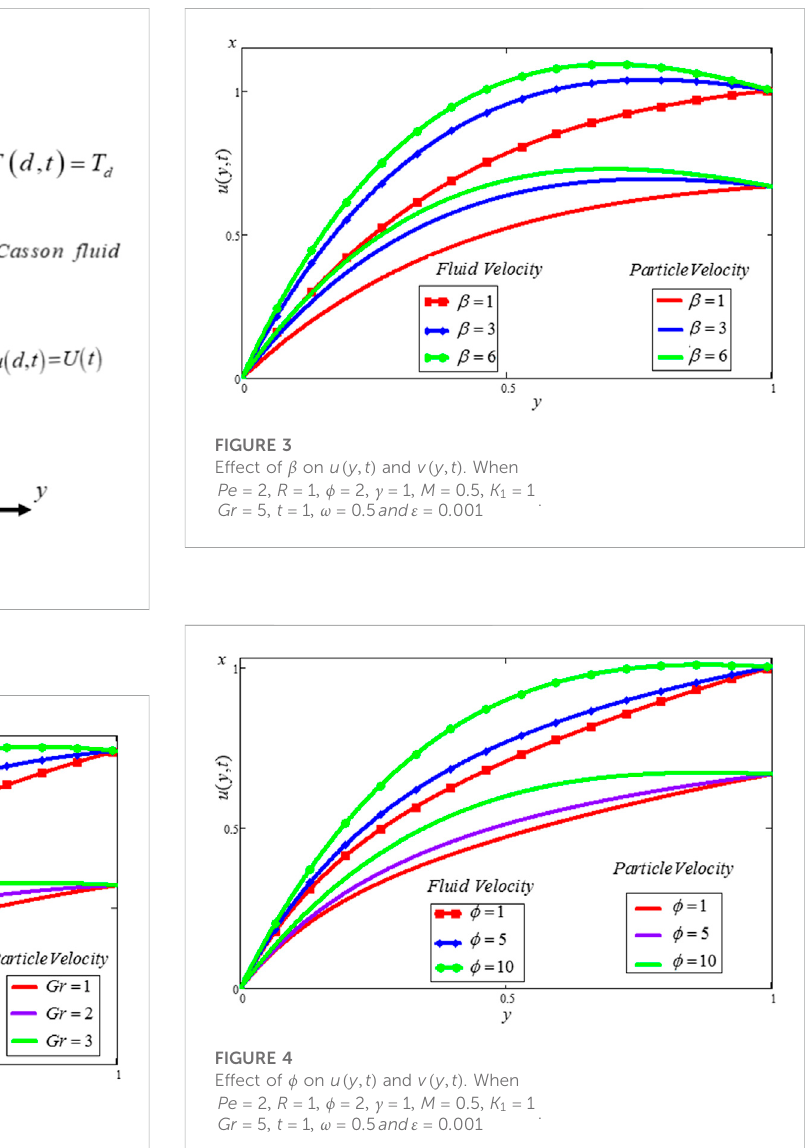
FIGURE 2 Effect of Gr on u ( y , t ) and v ( y , t ) . When Pe (cid:2) 2 , R (cid:2) 1 , ϕ (cid:2) 2 , γ (cid:2) 1 , M (cid:2) 0 . 5 , K Gr (cid:2) 5 , t (cid:2) 1 , ω (cid:2) 0 . 5 and ε (cid:2) 0 . 001 .